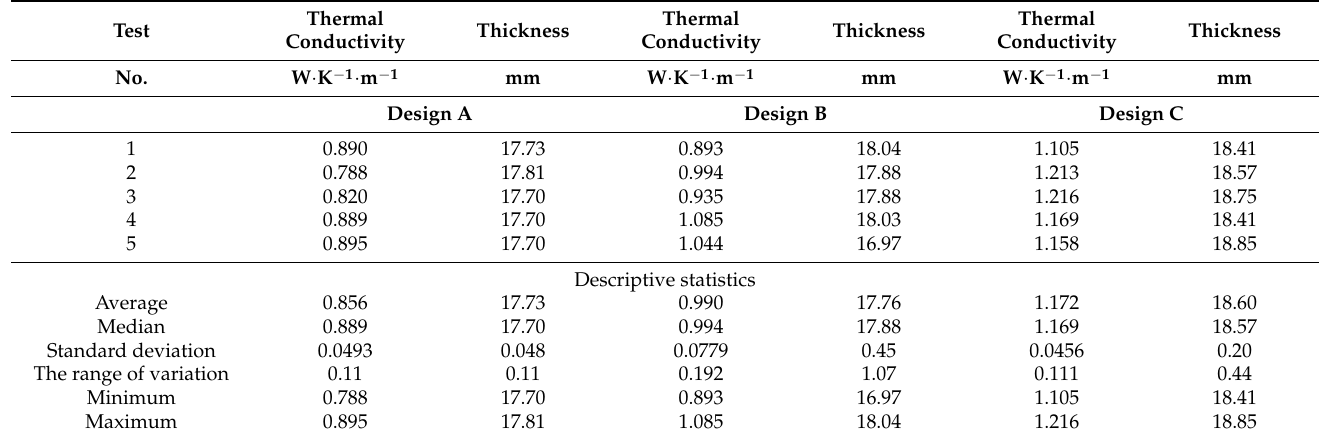
Table 4. Thermal conductivity test results for designs A, B and